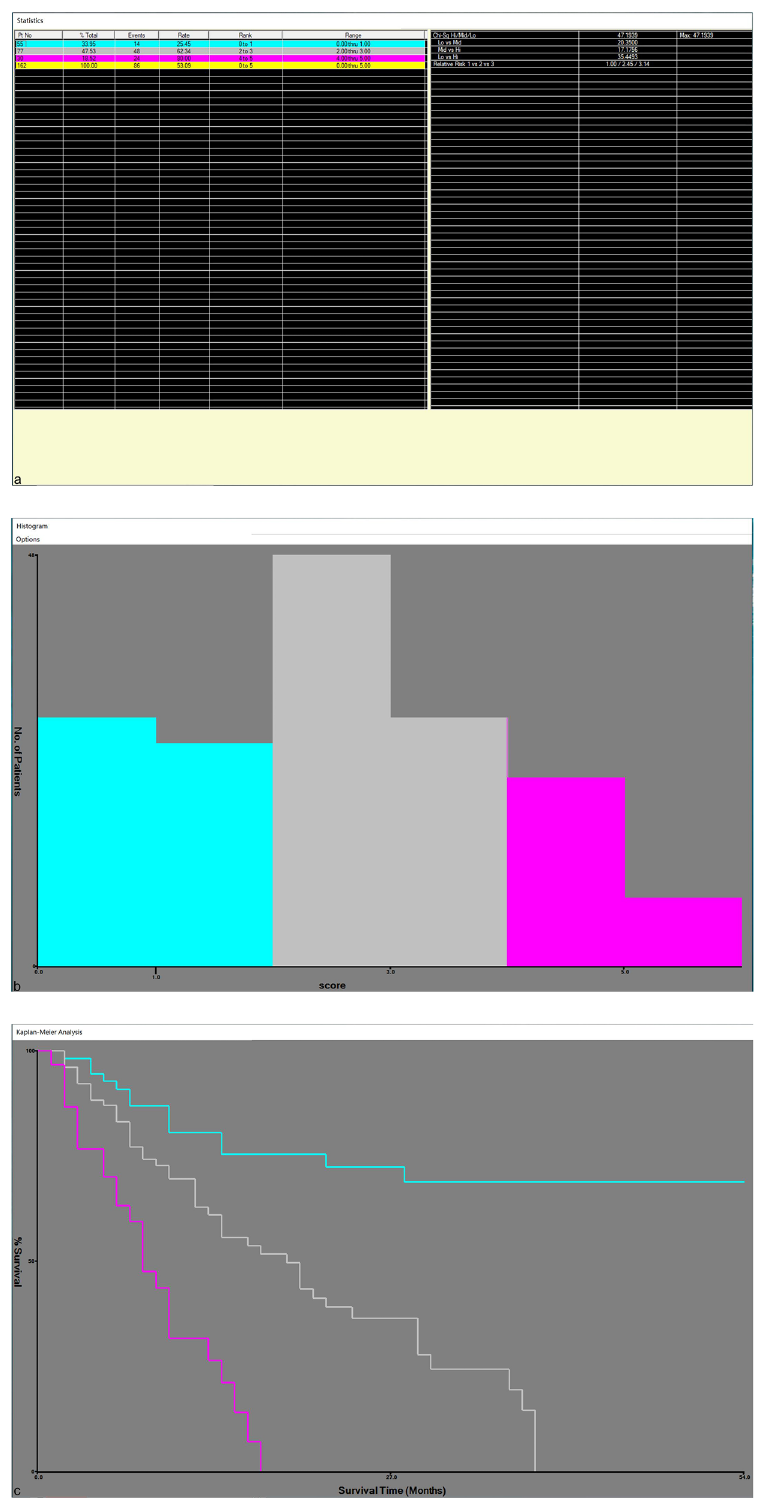
Figure 6. X-tile plots of predicted clinical scoring system and tumor-free survival of patients with HCC after percutaneous RFA. X-tile plots showing χ 2 values with cut-off points to generate Low-risk, Medium-risk and High-risk groups. ( a ) The optimal cut-off value of the clinical scoring system was 1 score and 3 scores at the maximum χ 2 value of 47.1939. ( b ) Histogram of the entire cohort divided into Low-risk, Medium-risk and High-risk groups according to the optimal cut-off value of 1 score and 3 scores. Blue bars represent the Low-risk group, grey bars represent the Medium-risk group, and red bars represent the High-risk group. ( c ) Kaplan–Meier plot of tumor-free survival in groups stratified using the optimal cut-off value of predicted clinical scoring system. Blue curves represent the Low-risk group, grey curves represent the Medium-risk group, and red curves represent the High-risk group. RFA Radiofrequency ablation; HCC Hepatocellular